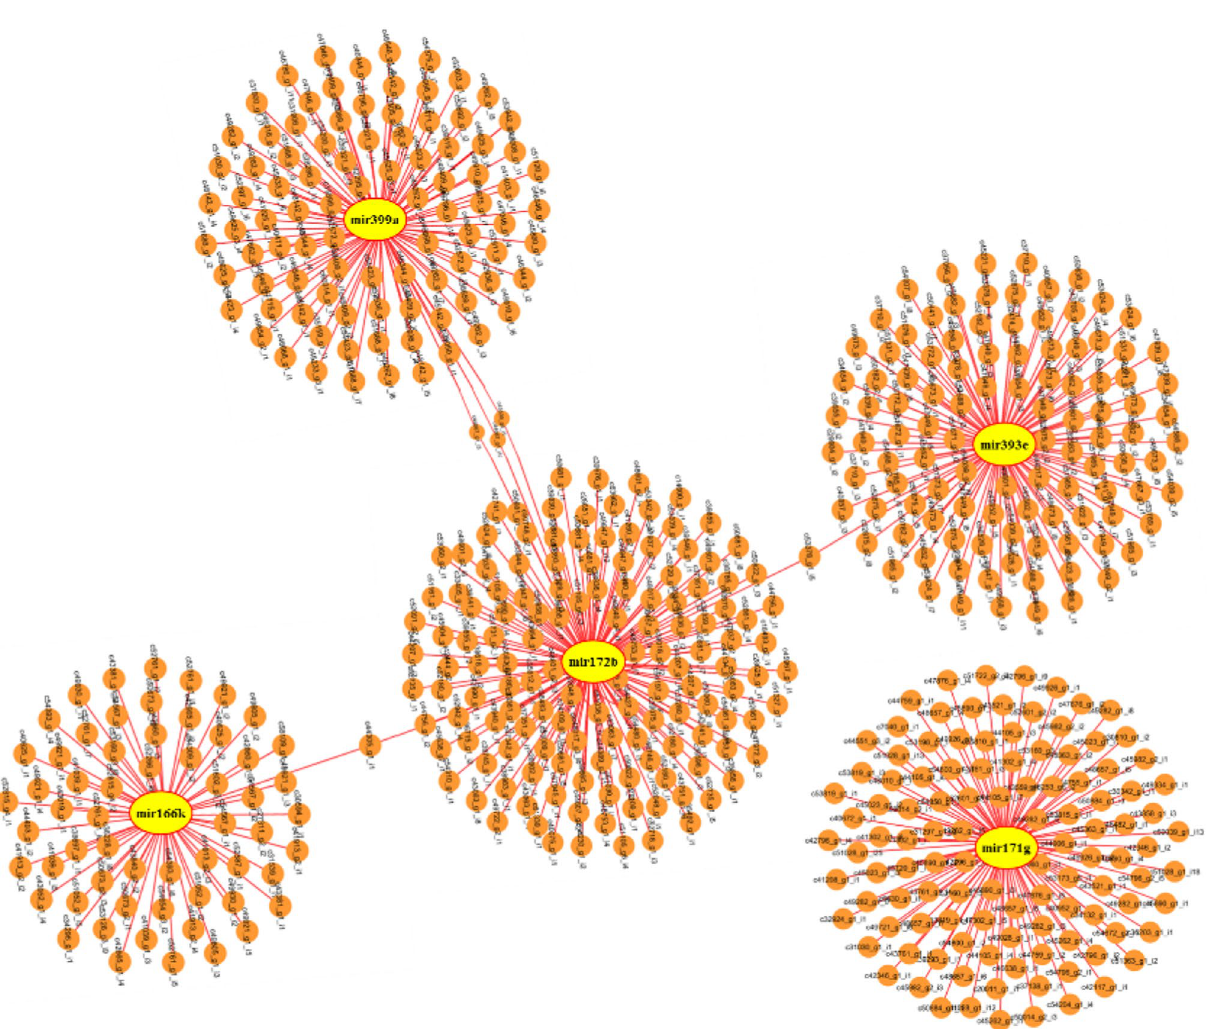
Figure 8. Regulation networks of five selected miRNAs with their 525 salt responsive coding target genes. miRNAs are represented by yellow nodes, and target genes are represented by orange nodes. The edges represent connections. Interaction networks was generated using the Cytoscape v2.8 55 (https:// cytos cape.